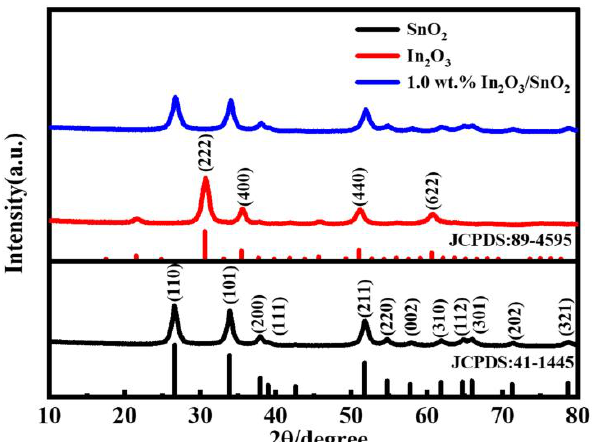
Figure 1. XRD patterns of pure SnO 2 , In 2 O 3 and 1.0 wt.% In 2 O 3 /SnO 2 composite photocatalysts.